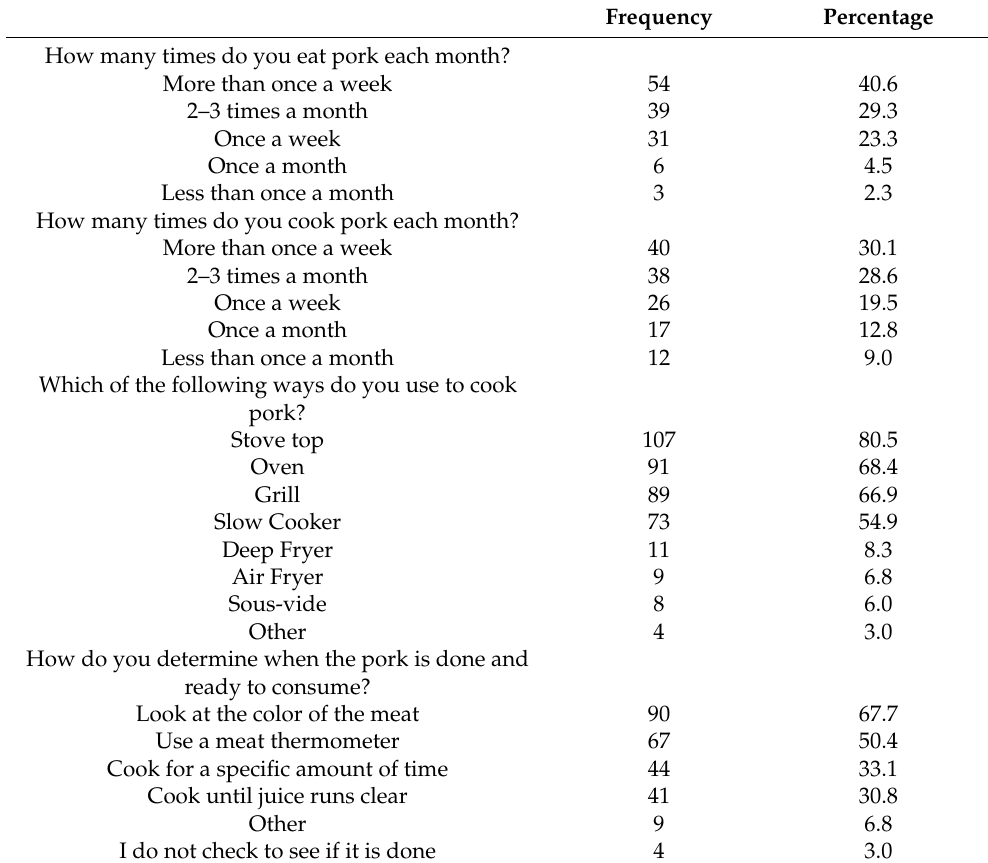
Table 5. Frequency and percentage of participants response to pre-survey questions (133